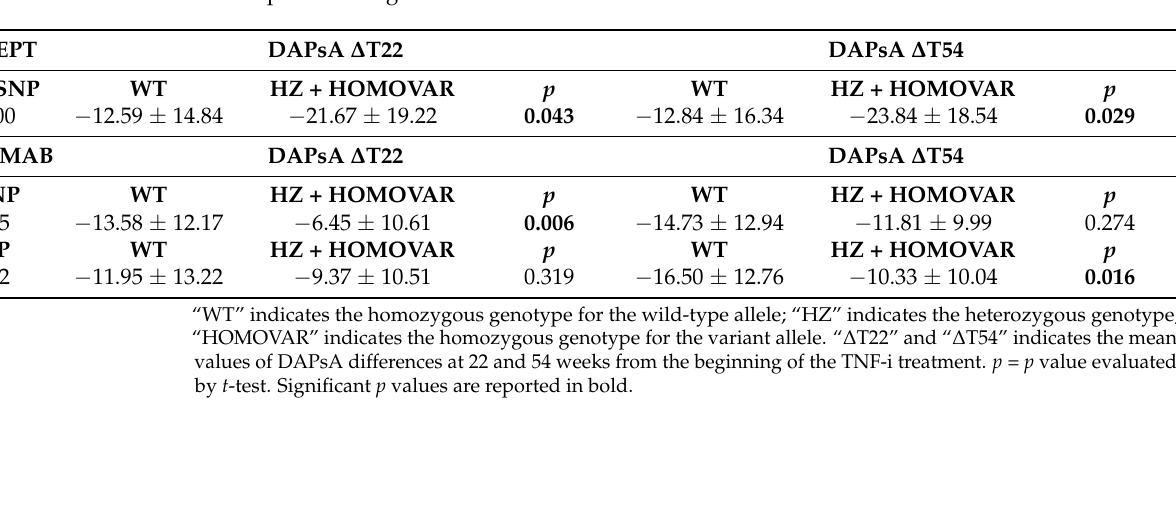
Table 4. Association analysis (according to dominant model) between TRAF3IP2 , STAT4 and IL10 and response to single TNF-i treatment in